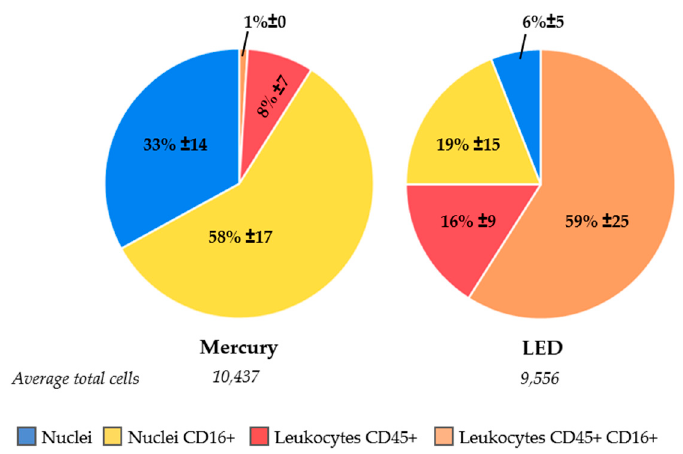
Figure 5. Improved identification of cells by comparison of cell population distributions analyzed with the mercury arc light source in CellSearch ( left ), followed by analysis with a LED light source on a separate microscope ( right ).